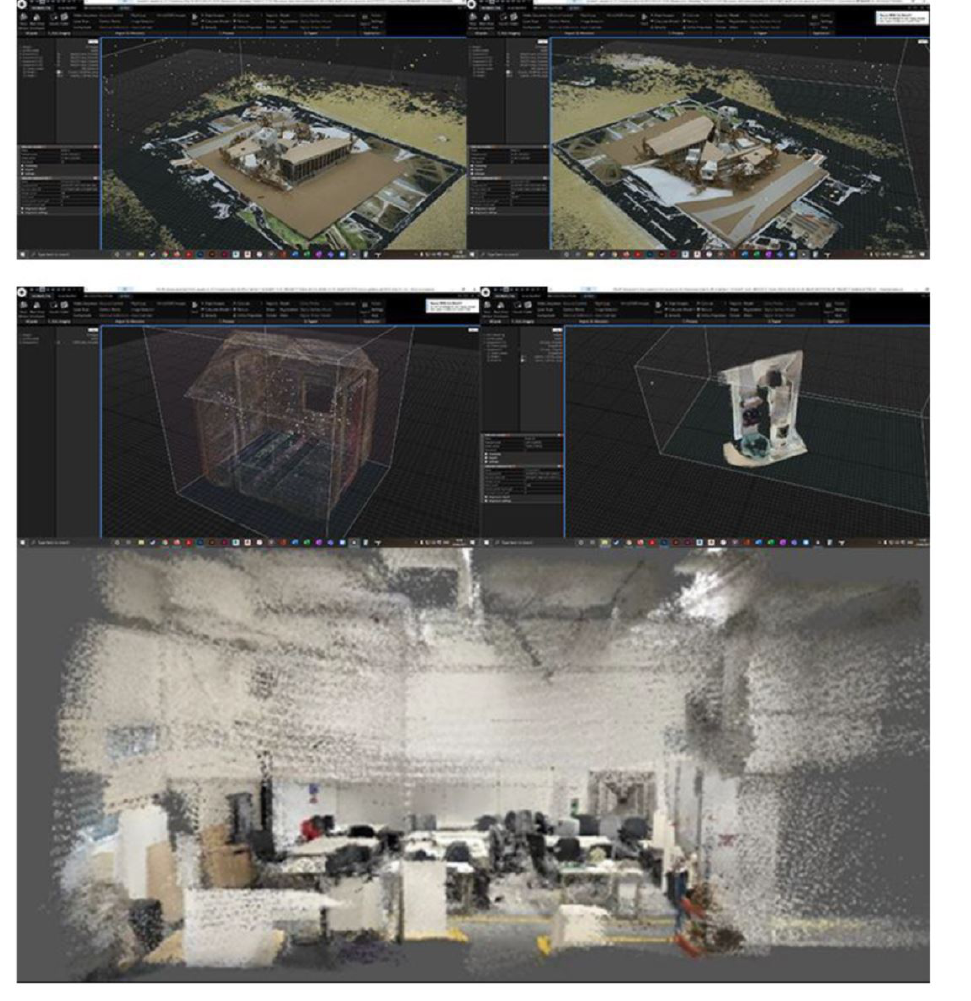
Figure 9. New experiments in capturing the reality of spaces and models: experiences and process (Source: Simon Kay-Jones and Louise Janvier,